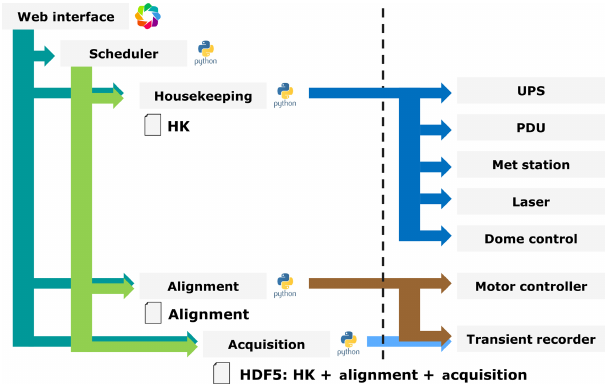
Figure 3. Block diagram of the new acquisition and lidar control software. Table 1. Number of experiments conducted during 2018 as part of the TROPOMI validation and NDACC activities. Measurements re- ported for September are only up to 13